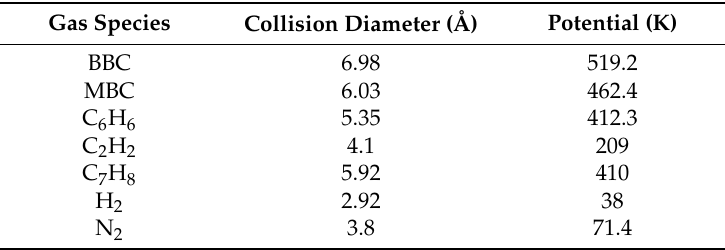
Table 3. Lennard-Jones parameters for species used in the